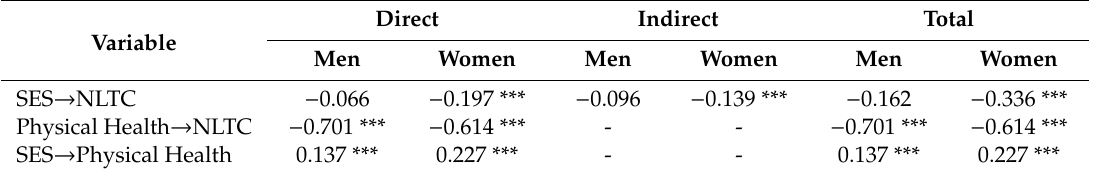
Table 5. Standardized E ff ects between SES, Physical Health and NLTC by Gender.